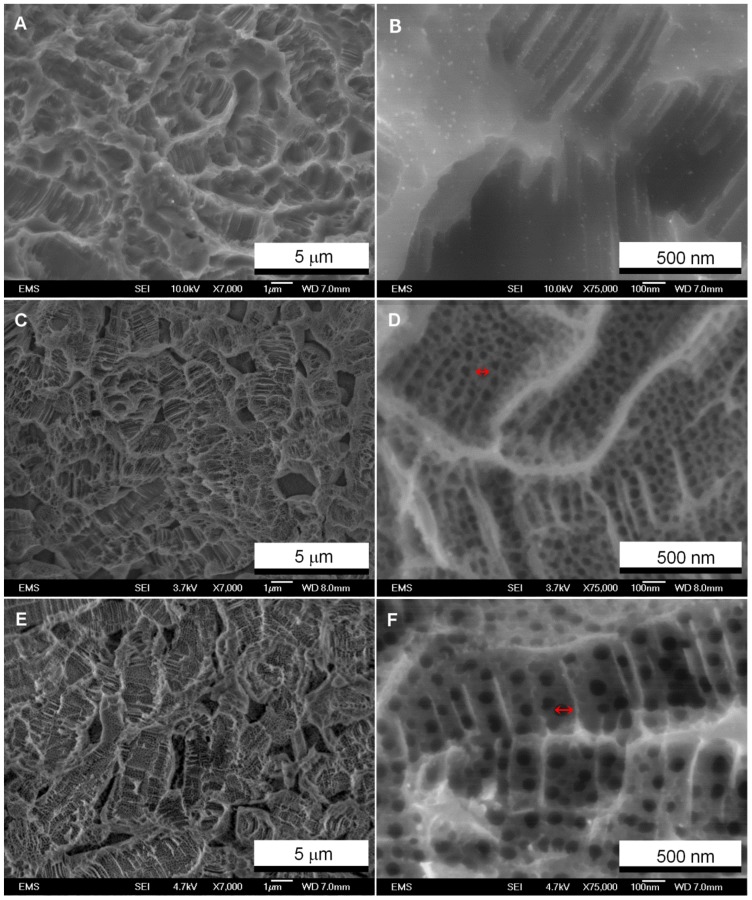
FESEM images of the surfaces.Images of non-anodized surface ((A) and (B)), 20 V anodized surface ((C) and (D)), and 60 V anodized surface ((E) and (F)) demonstrate formation of TiO2 nanotubes on anodized samples. Low magnification is shown at left side (A, C and E) and high magnification is shown on the right side (B, D and F).